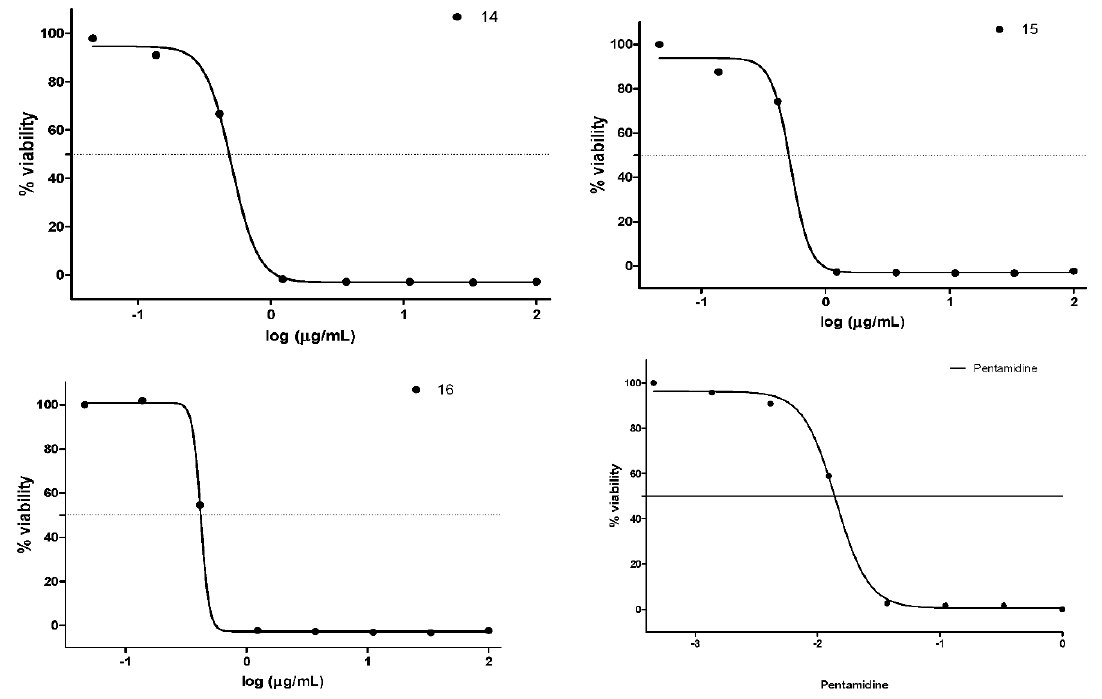
Figure 3. Dose-dependent curves of the antitrypanosomal activity of chloroform (14), ethyl acetate (15) and ethanol (16) extracts of O. genistifolia .